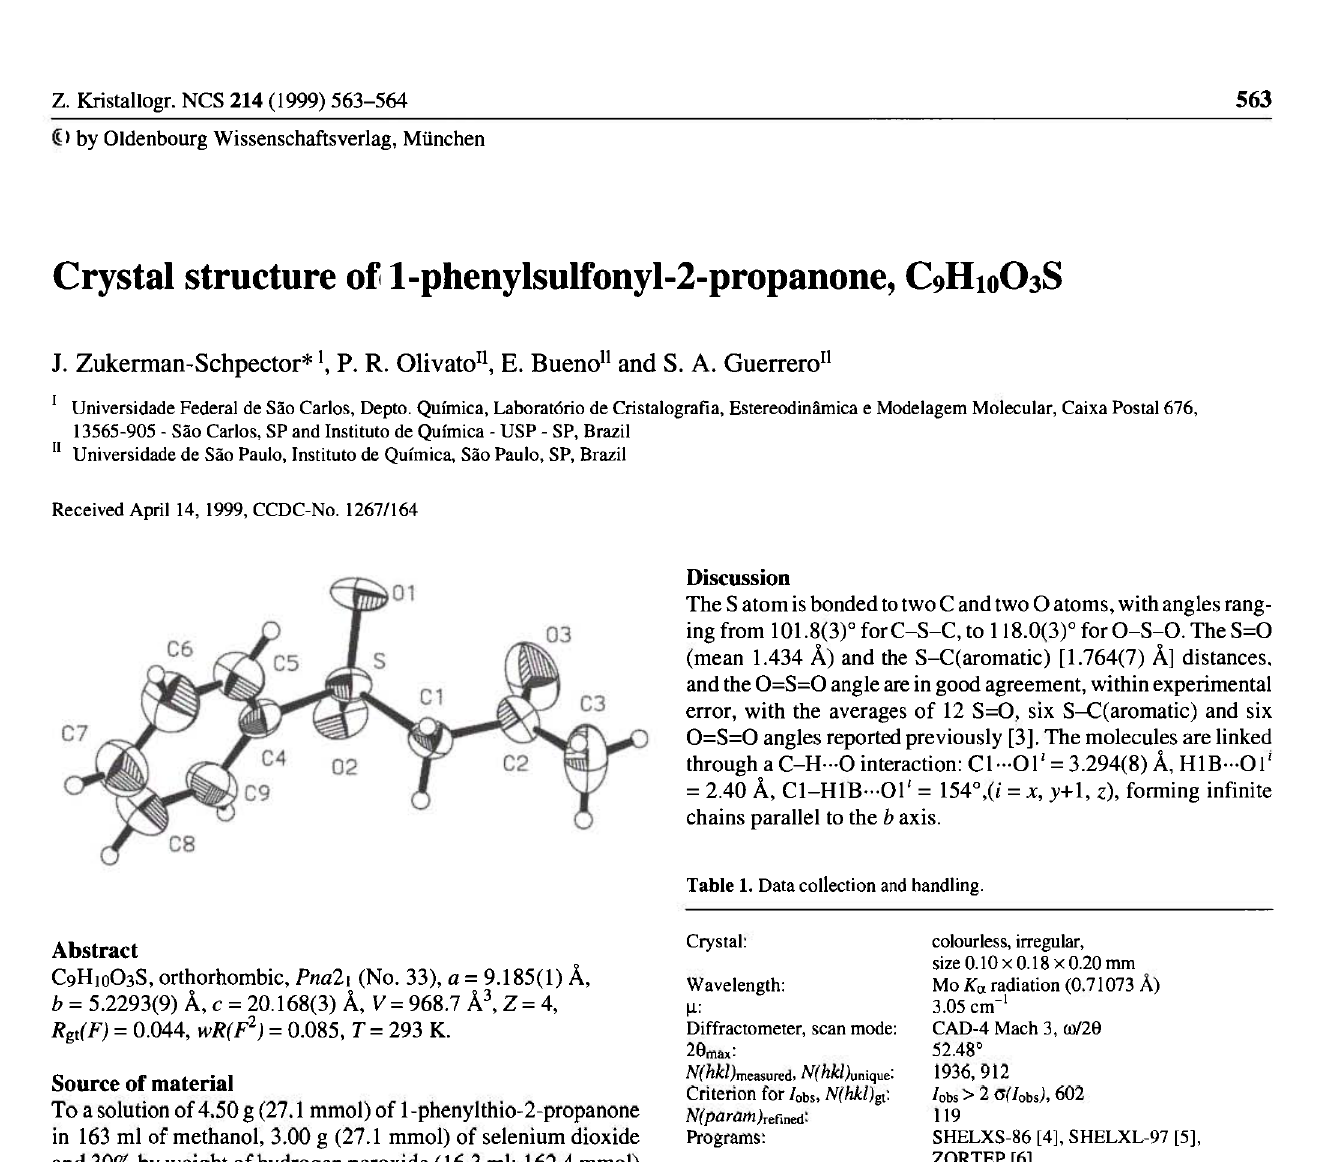
Table 2. Atomic coordinates and displacement parameters (in Ä 2